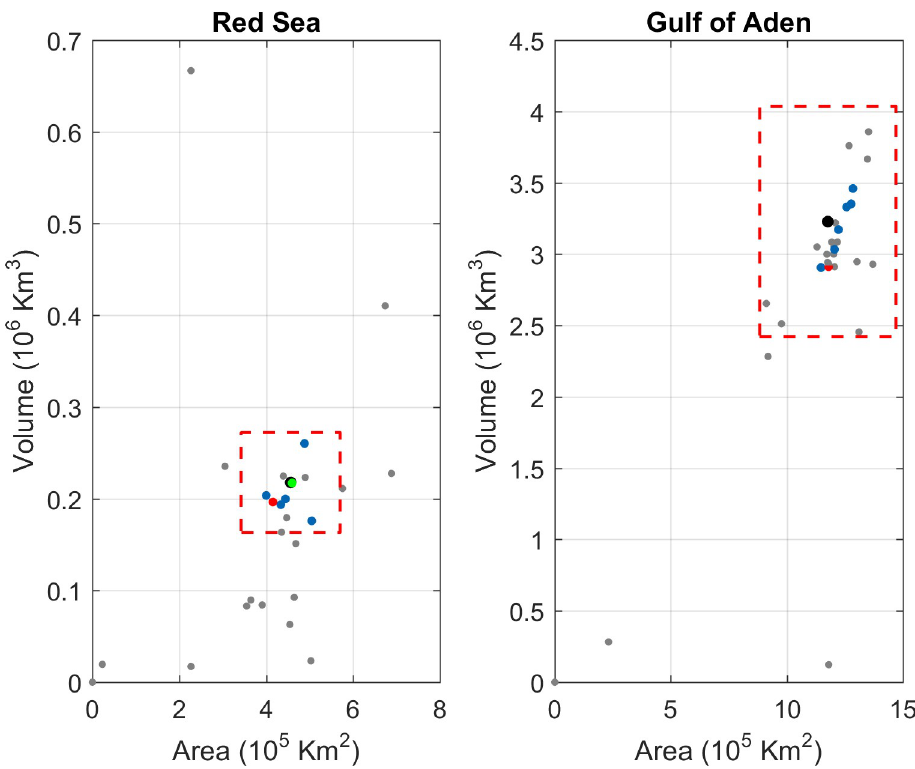
Fig 2. Scatter that represents area (x-axis) against volume (y-axis) for each GCM (grey dots) and the reference simulations (GLORYS in red and KAUST in green). The observed values are indicated by the black dots and the acceptble threshold ( ± 25% with respect to the observed value) is represented by the dashed red line. The results are shown for the Red Sea basin (left panel) and the Gulf of Aden (right panel). Note that KAUST simulation does not cover completely the Gulf of Aden and is therefore not included in the right